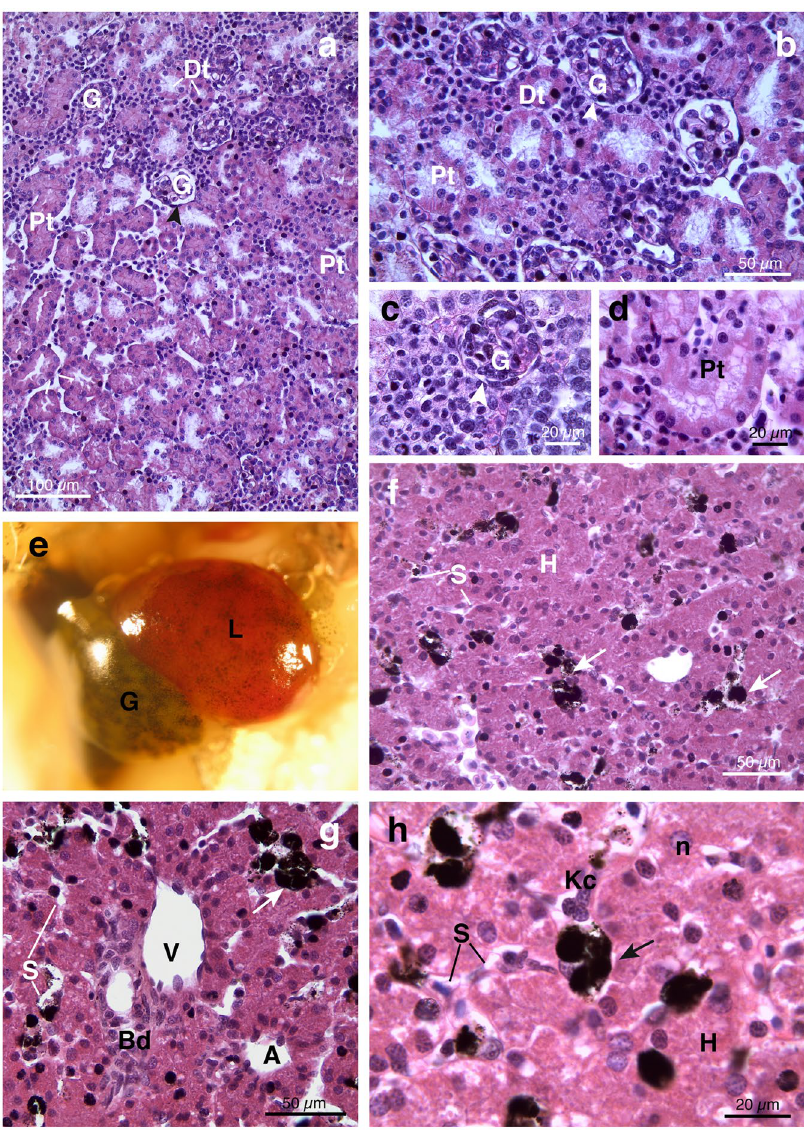
Figure 2. Representative photomicrographs and histological sections of kidney and liver from Hyla intermedia juveniles under basal condition. ( a , b ) Renal parenchyma showing typical architecture with filtration unit, the capsule of Bowman surrounding the glomerulus, and renal tubules. ( c ) Particular of renal corpuscles formed by a globular mass of specialized capillaries, enclosed into the Bowman’s capsule. ( d ) Note the luminal brush borders of the proximal tubules. (G = glomerulus; Dt = distal tubule; Pt = proximal tubule; arrowheads = Bowman’s capsule). ( e ) External view of liver showing an orange-brown color and pigmented cells. A large dark-green gallbladder is also visible. ( f ) Histological section showing the homogenous arrangement of hepatic tissue. ( g ) Hepatic portal area constituted by bile duct, branches of both portal vein and hepatic artery. ( h ) Particular at higher magnification showing large hepatocytes with rounded nuclei and granulated cytoplasm; Kupffer cells are anchored to sinusoid endothelium. (L = liver; G = gallbladder; H = hepatocytes; S = sinusoid; V = branch of the portal vein; A = branch of the hepatic artery; B = bile duct; Kc = Kupffer cells; n = nucleus; arrows = melanomacrophages complex). All cross-sections are